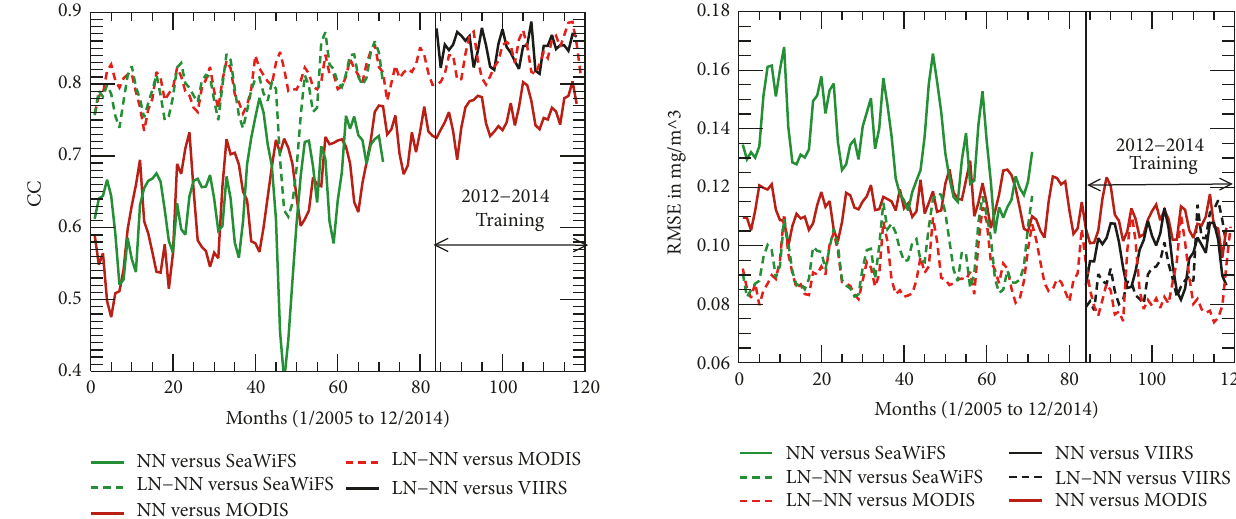
Figure 11: RMSE of monthly mean chl-a concentrations simulated byNN(solid)andLN-NN(dashed)ensemblesversusVIIRS(black), MODIS (red), and SeaWiFS (green) data. chl-a output (solid lines) and (2) an ensemble of LN-NNs having ln ( chl-a) output (dashed lines). Comparisons of the ensemble means with observations (VIIRS (black), MODIS (red), and SeaWiFS (green)) are